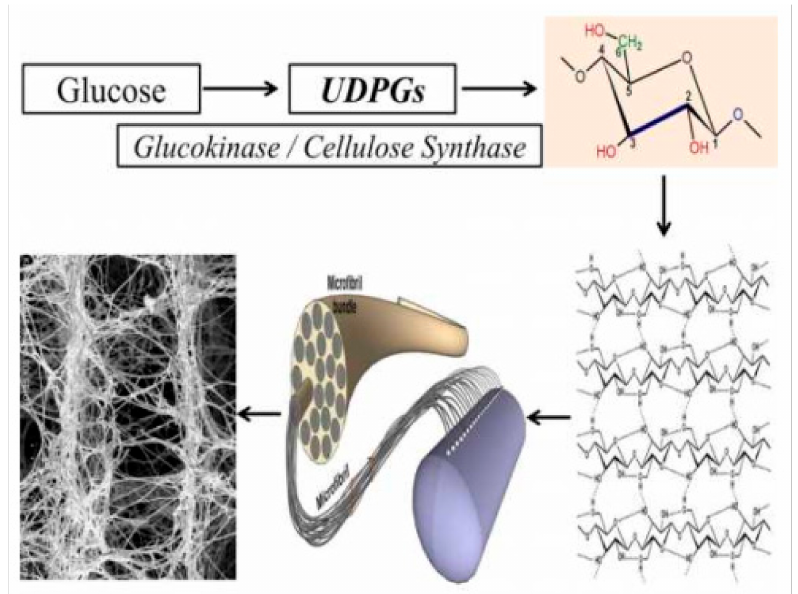
Figure 4. Structural organization of bacterial cellulose. A general overview (Courtesy Suleva et al., 2015). Characterization of bacterial cellulose (BC) or regenerated BC (RBC) based drug